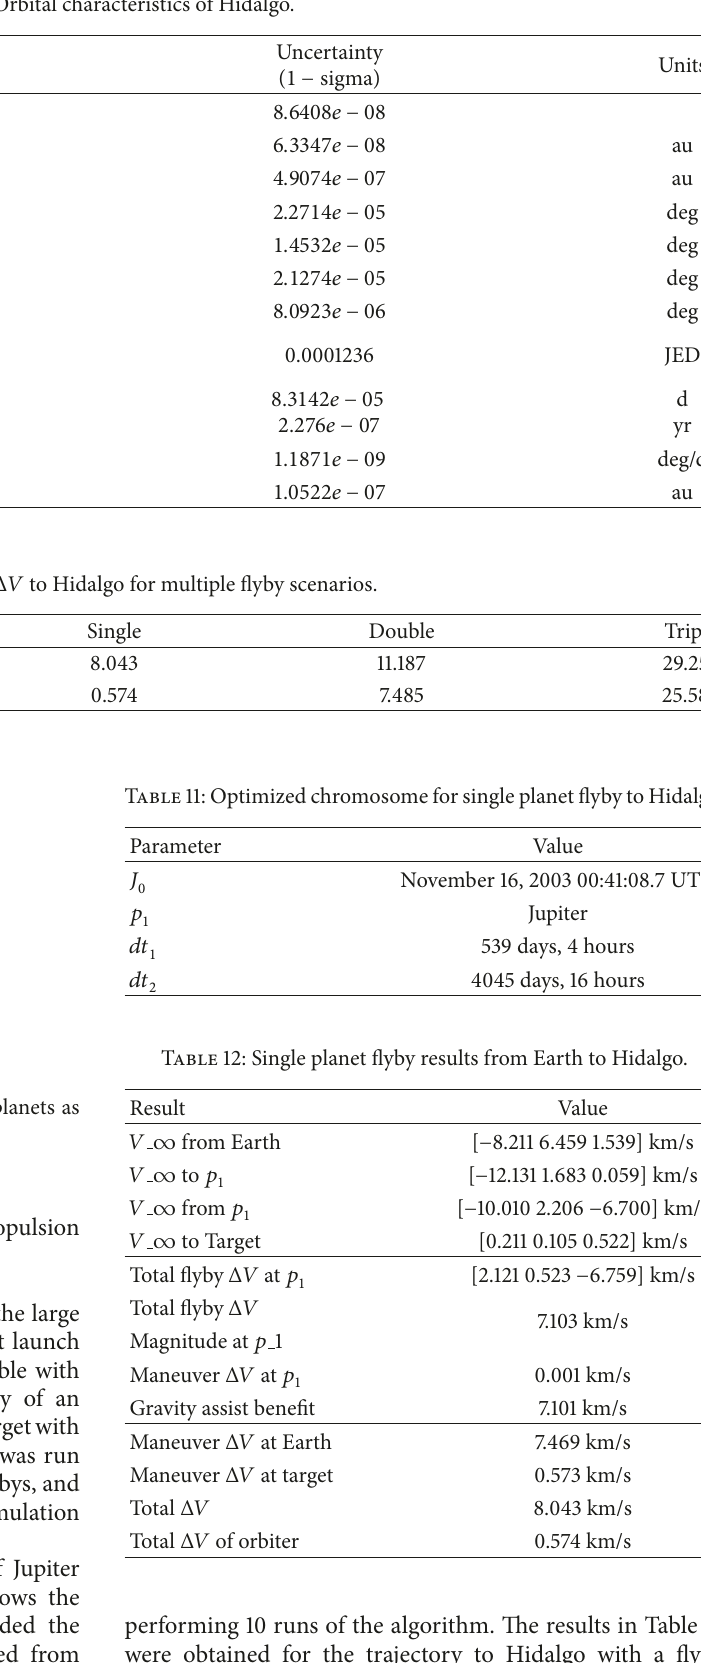
Table 9: Orbital characteristics of Hidalgo.